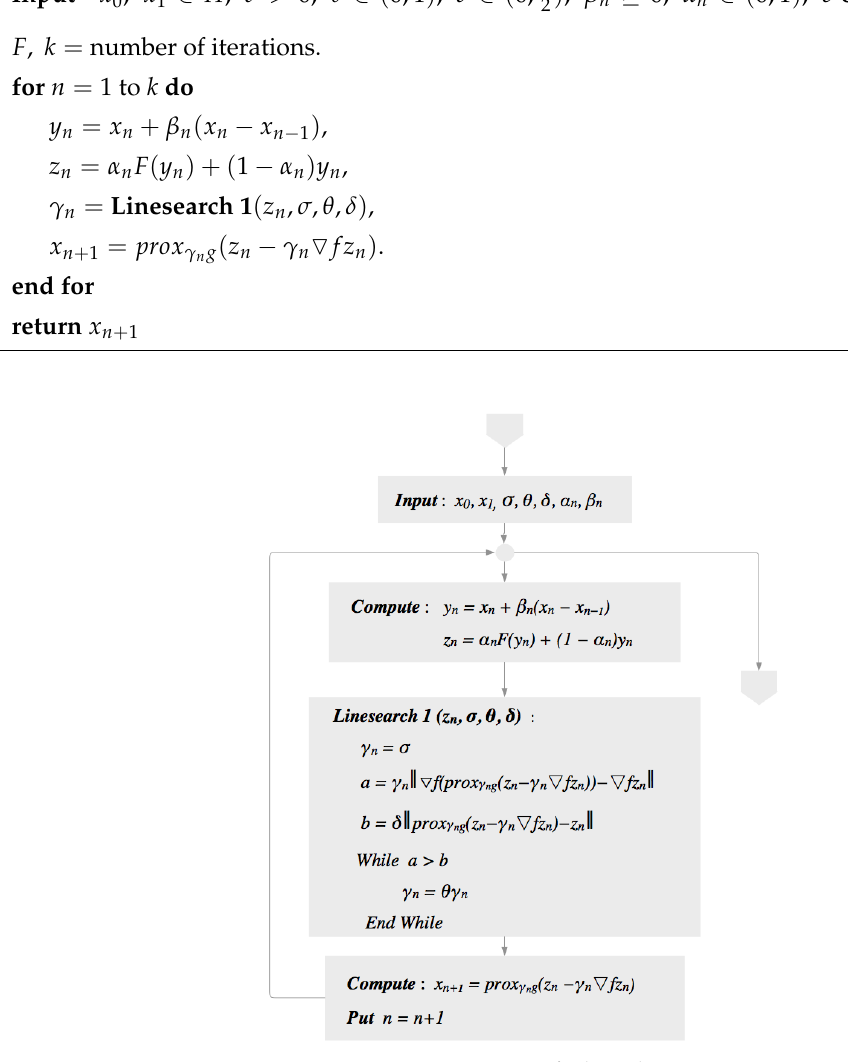
Figure 1. Diagram of Algorithm